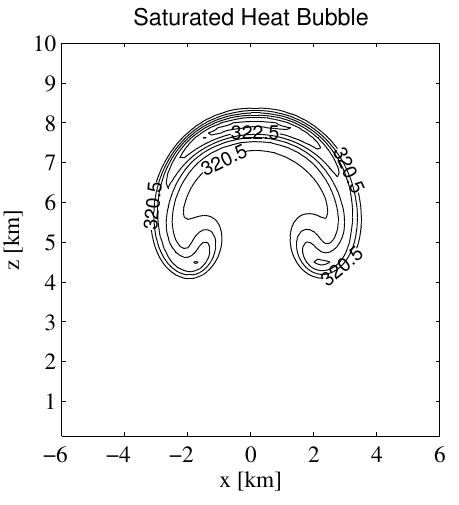
Fig. 6. DYCOMS-II: domain averaged liquid water path for the Simulations with 65 mg − 1 (N65) and 500 mg − 1 (N500) initialized cloud condensation nuclei